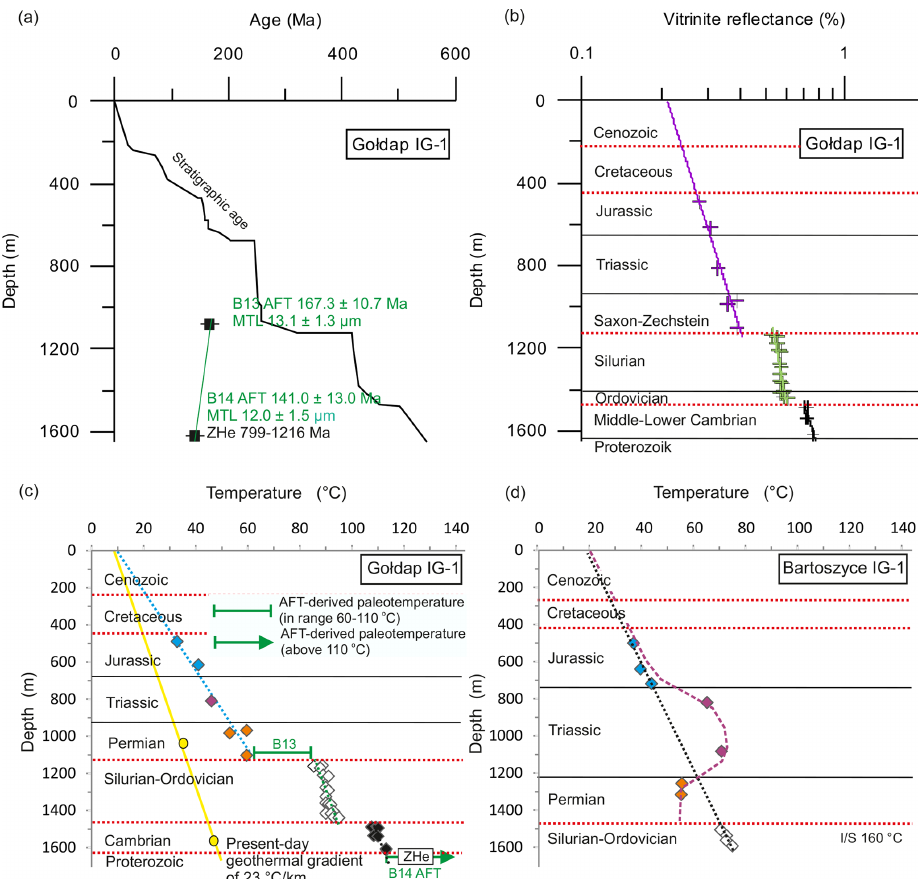
Figure 7. Gołdap IG-1 borehole data (eastern part of the Baltic Basin). (a) AFT ages vs. stratigraphic age in the Gołdap IG-1 well (ZHe age not to scale), (b) vitrinite reflectance (VR) profile in the Gołdap IG-1 well. (c) Paleotemperature profile: inferred Mesozoic profile (dotted blue line) shows no exhumation with paleogeothermal gradient of ≈ 45 ◦ Ckm − 1 ; inferred Ordovician–Silurian profile (dotted green line) shows 3km exhumation with paleogeothermal gradient of 33 ◦ Ckm − 1 . (d) Bartoszyce IG-1 paleotemperature profile – the bell-shaped curve (e.g. Ziagos and Blackwell, 1986) suggests transient fluid flow due to lateral migration in Triassic rocks. Significant discrepancy between VR eq-derived paleotemperature ( ≈ 75 ◦ C) and illite-/smectite-derived paleotemperature (I/S = 160 ◦ ); not to scale, data from Kowalska et al. (2019) exist in the upper part of Silurian strata that can be also caused by fluid flow. For other explanations, see Fig.